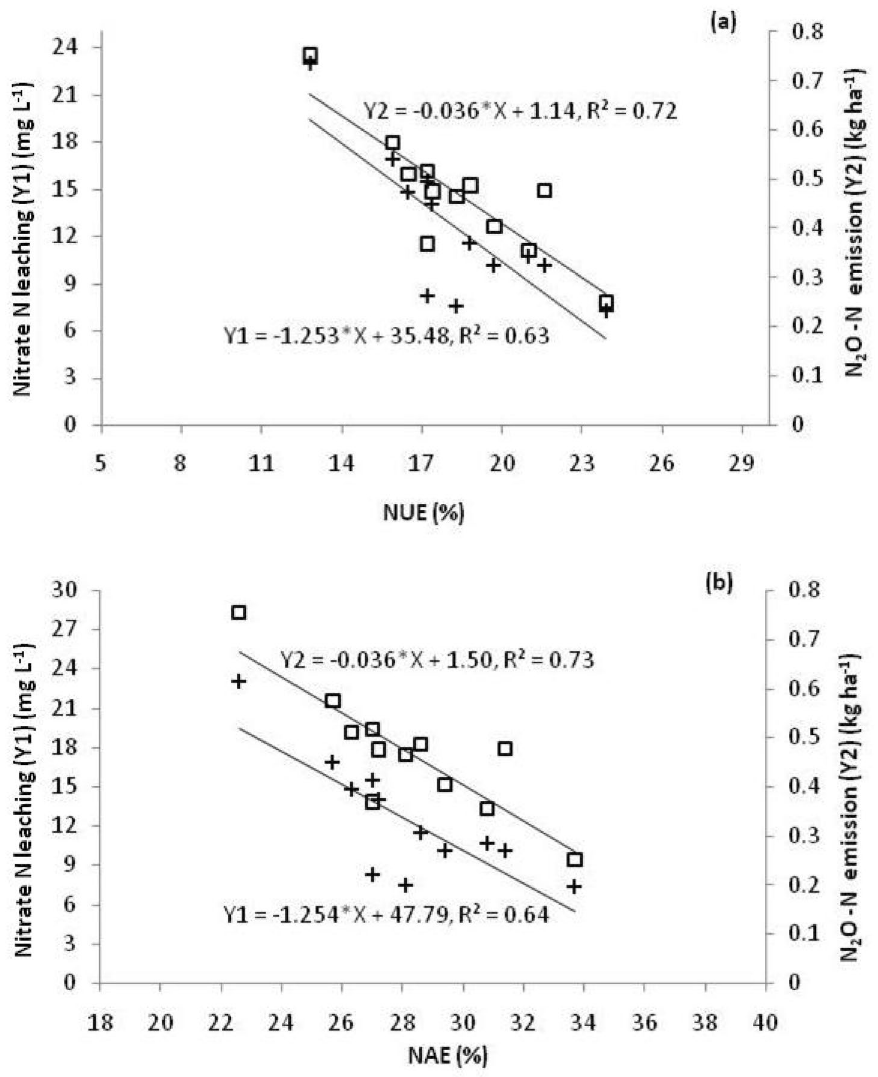
Figure 3. Relationship between Nitrogen losses and ( a ) nutrient use and ( b ) nutrient accumulation efficiency in saffron growing cold humid region of North West